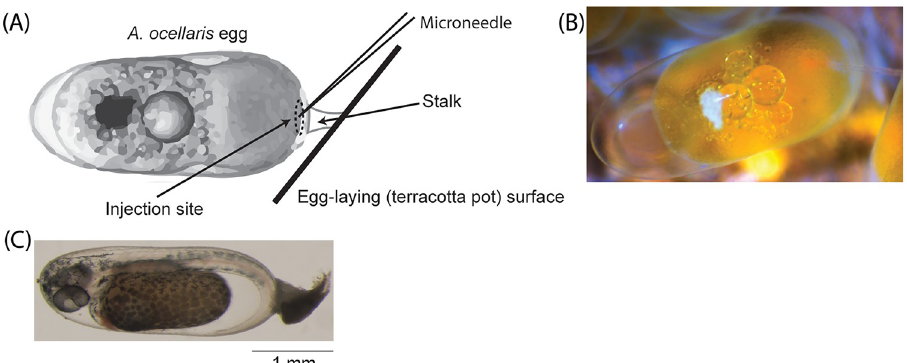
Fig 1. Egg microinjection site and embryo appearance. (A) Illustration depicting an Amphiprion ocellaris egg ( < 1-hour post-fertilisation) with demarcated injection site at the animal pole. (B) Brightfield micrograph of a live A . ocellaris egg injected by a microneedle with released fluid marked by red-fluorescent dye. (C) Wild-type A . ocellaris embryo at 64–88 hours post-fertilisation with formed eyes and pigmentation.